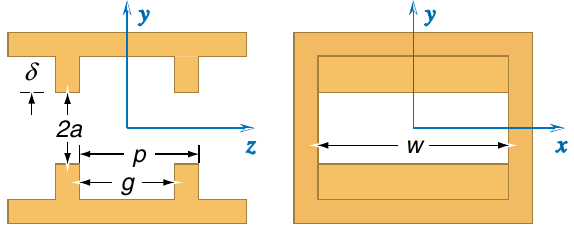
FIG. 1. (Color) A longitudinal cut of the structure geometry considered here, showing two periods in the z - y plane (left), and a transverse cut showing the cross section of the structure